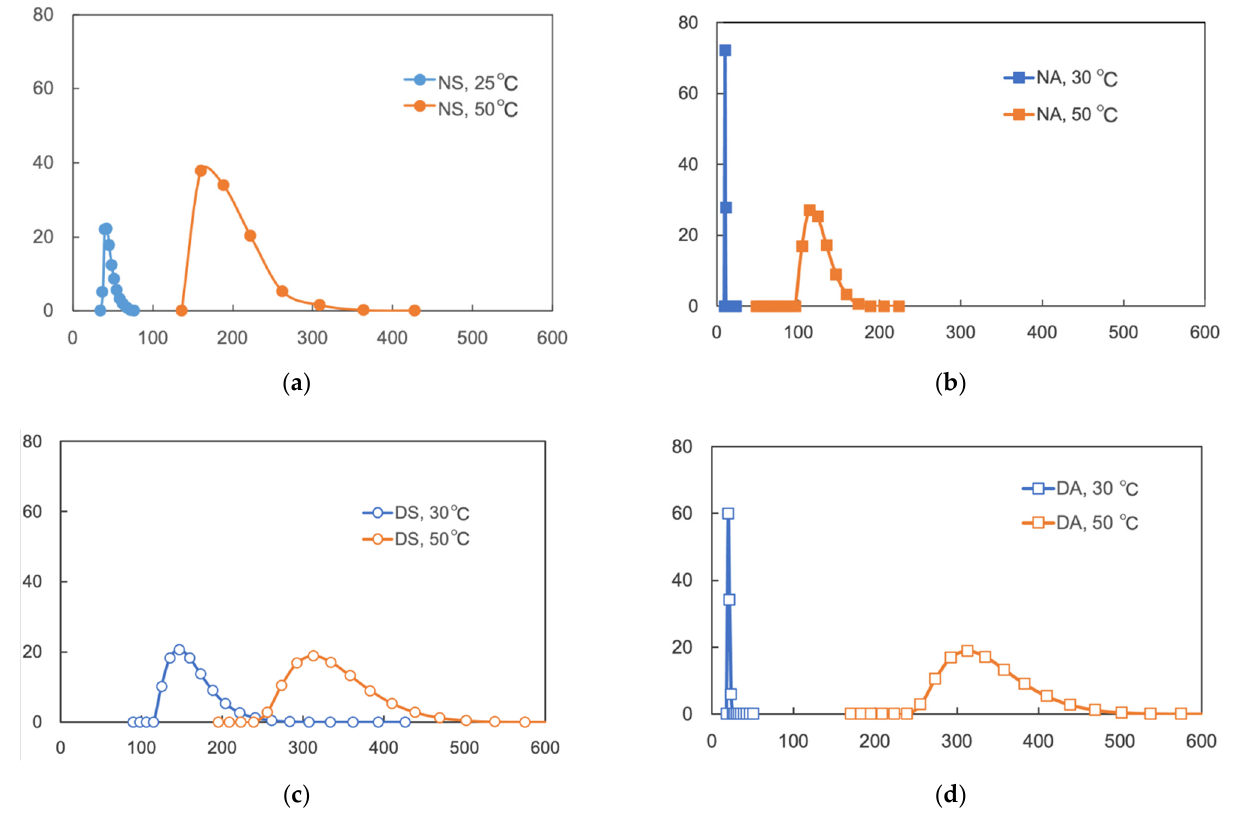
Figure 4. DLS of the copolymers in aqueous solutions at 30 °C and 50 °C. ( a ) NS [45], ( b ) NA , ( c ) DS , and ( d ) DA .